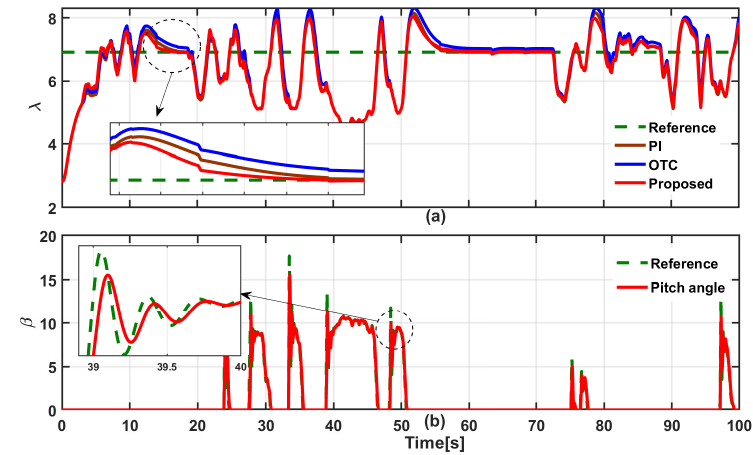
Figure 15. Results for case III with real wind speed. ( a ) Tip speed ratio λ . ( b ) Pitch angle β .